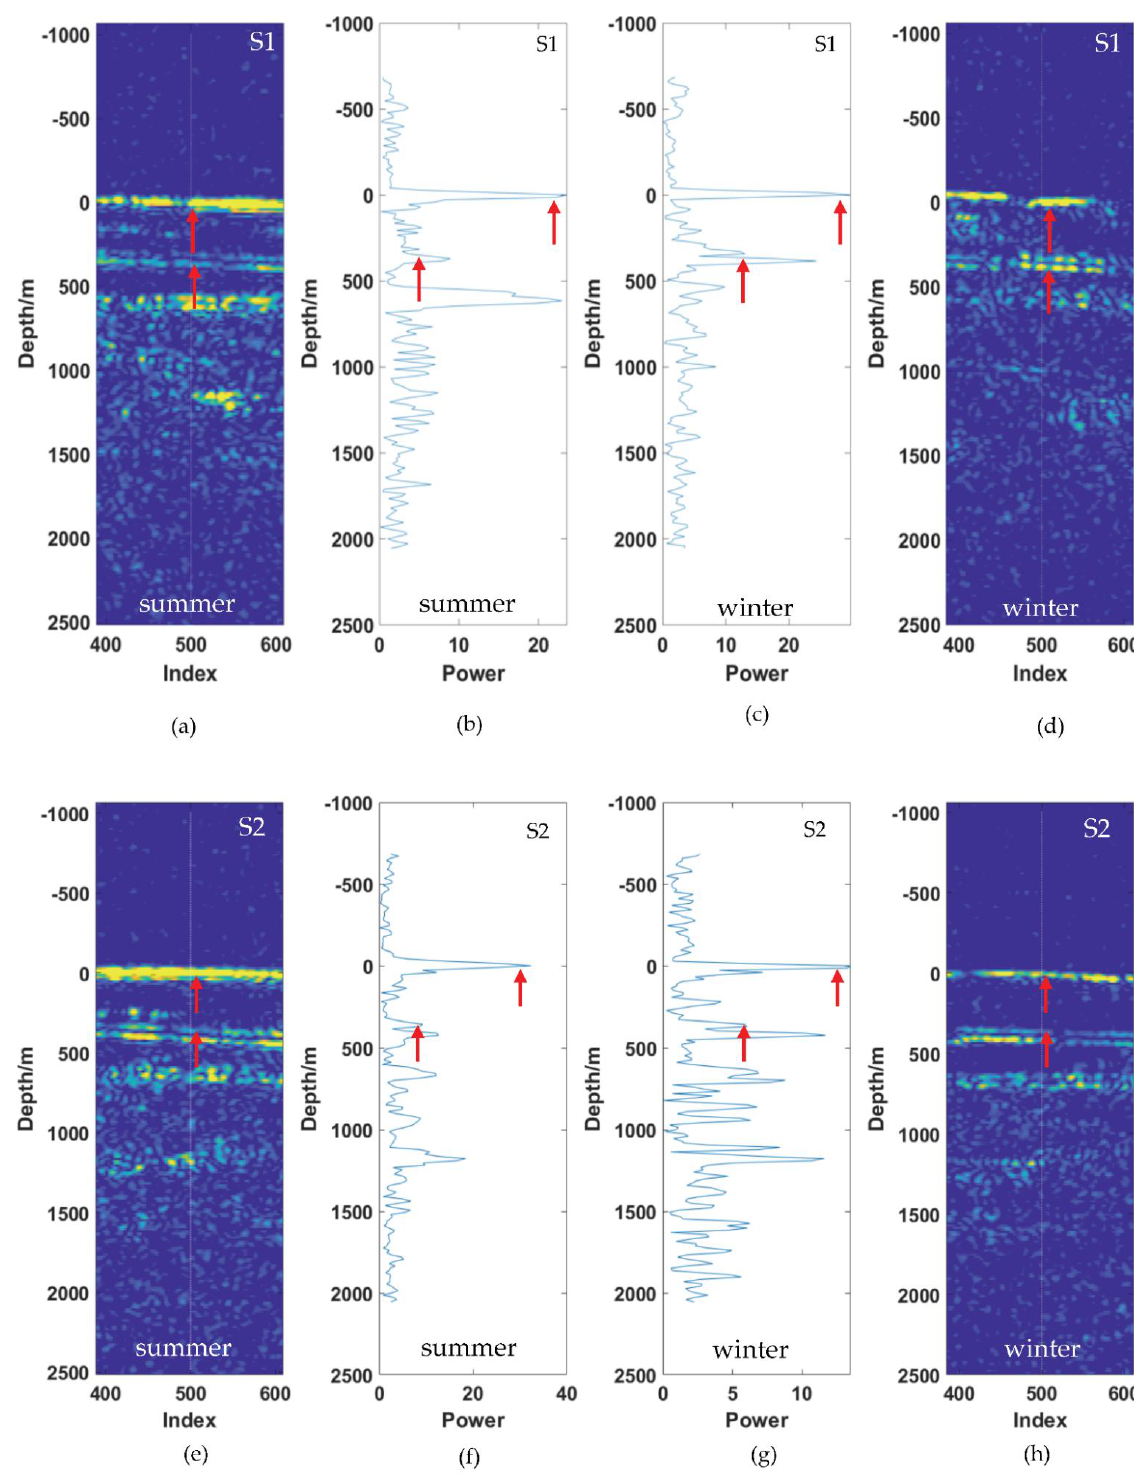
Figure 7. Comparisons of radargram and radar power profile in summer and winter seasons. The parameters of the first set of subsatellite points shown in ( a – d ) are given in Table 1. The parameters of the second set of subsatellite points shown in ( e , f ) are given in Table 2. Figure ( a , e ) are the radargram and ( b , f ) are corresponding echo power plot of the subsatellite point in the summer. Figure ( c , g ) are the radargram and ( d , h ) are the corresponding echo power plot of the subsatellite point in the winter. For the first set of data points, the thickness of AA 3c in the summer is 348.8 m, and the thickness is 379.2 m in winter, the ∆ d is 30.4 m. The arrows on the profile mark the position of both the surface and the subsurface echo, which correspond to the signal peaks marked in the power